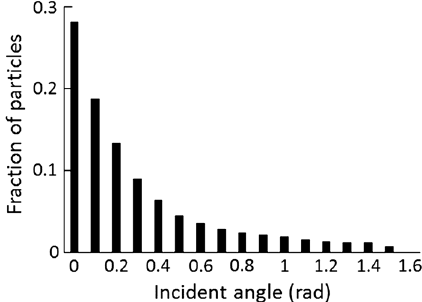
code.FIG. 3. Most particles hit the vacuum chamber at small angles to the normal.